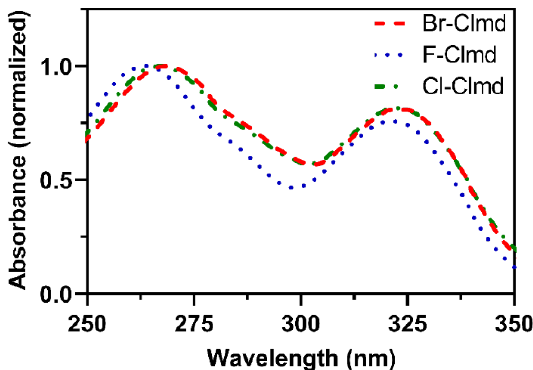
Figure 3. UV – Vis spectra of the halogenated Clmds in aqueous solution. Figure 3. UV–Vis spectra of the halogenated Clmds in aqueous